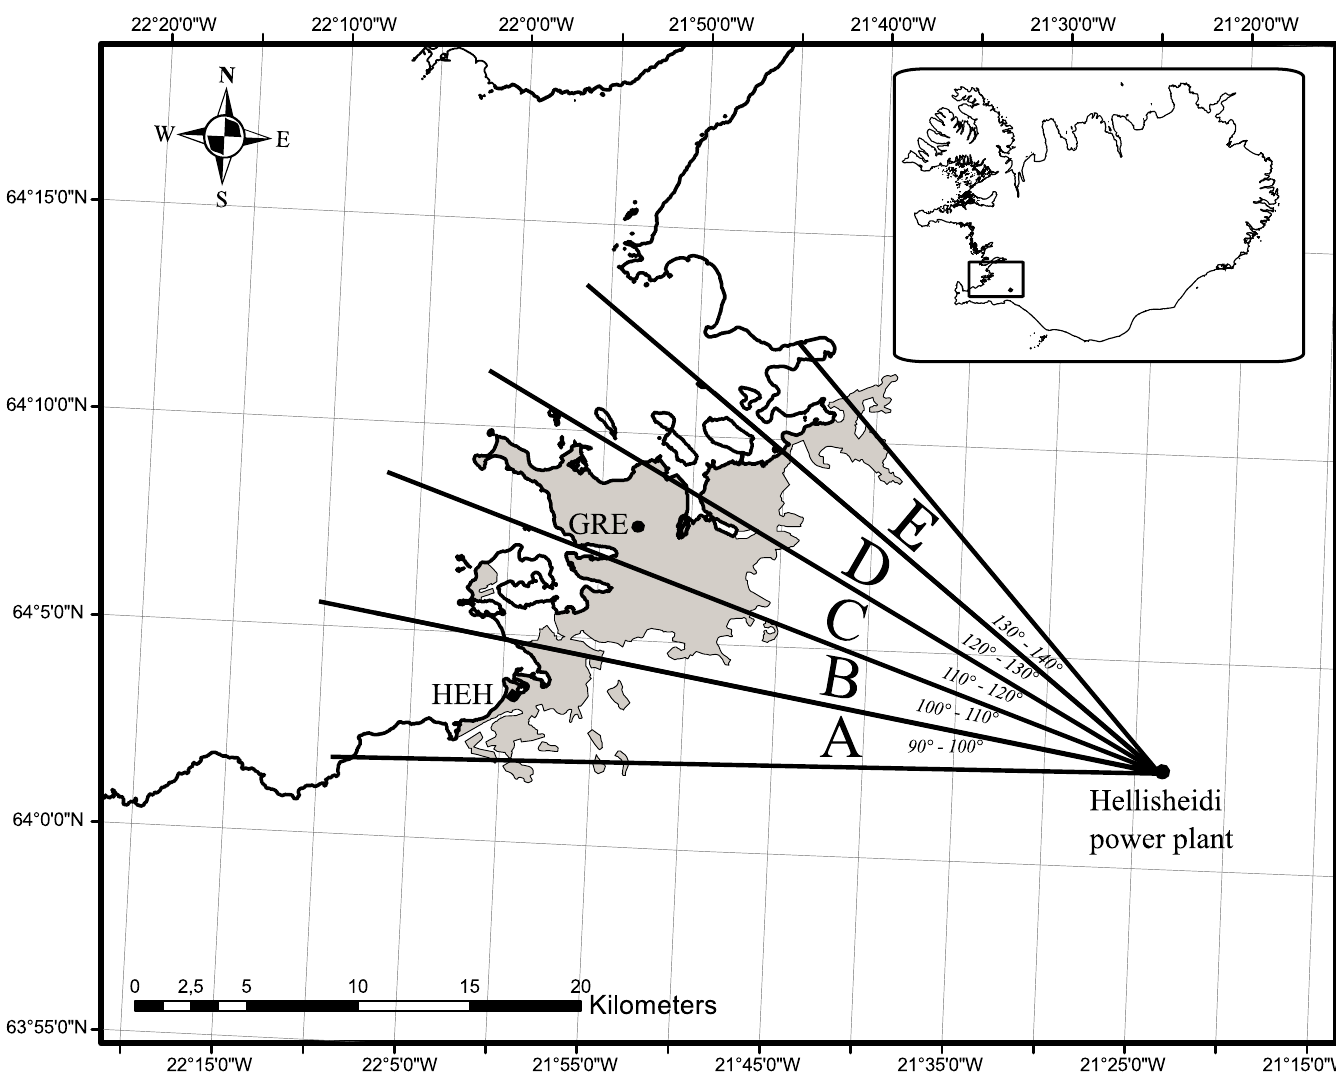
Fig 1. Five modelled sections (A to E) of the Reykjavik capital area (the shadowed area), and the point source of H 2 S emissions, the Hellisheidi power plant. Small inserted map shows Iceland and the capital ’ s